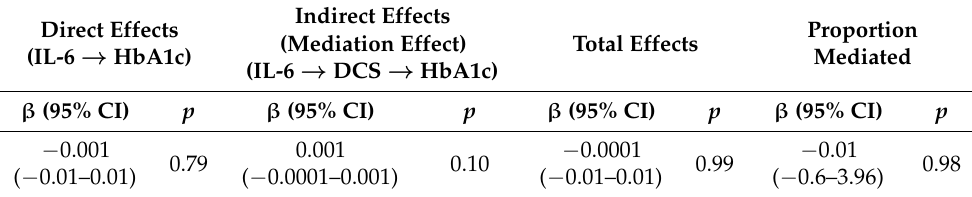
Table A1. Standardized effects ( β estimate, 95% CI) and p -values of IL-6 on HbA1c via diurnal cortisol slope (DCS) as a mediator, and the proportion of association between IL-6 and HbA1c mediated by cortisol ( n = 758).